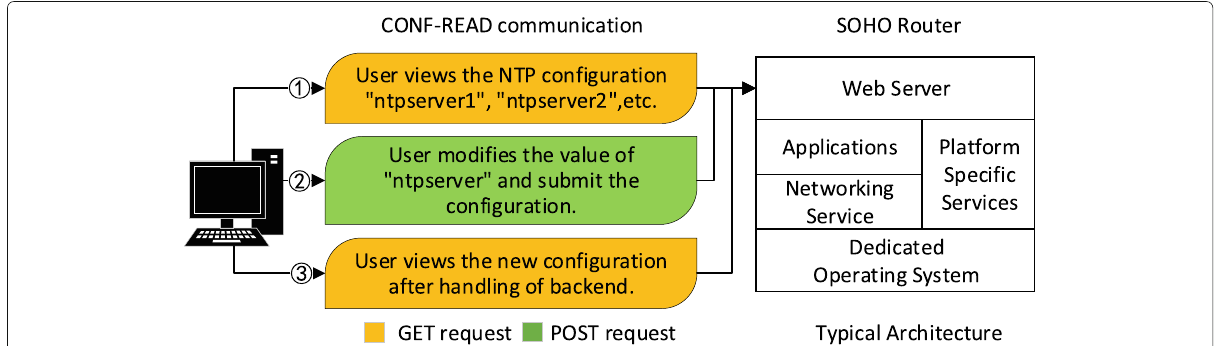
Fig. 1 Typical architecture of SOHO router and the workflow of the NTP configuration